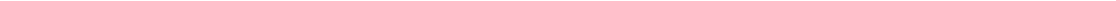
Fig. 2 The basal yeast thiol oxidation landscape. a Distribution of the in vivo oxidation status of 4,457 unique cysteine-containing peptides. The dataset was classi fi ed into four oxidation groups as indicated. For each group, a representative peptide (red) and the respective extracted ion chromatogram (XIC; right) are shown. XICs display the redox state of (I) Cys157 of the methionine-R-sulfoxide reductase Mxr2, (II) Cys107 of the translational mRNA activator Gis2, (III) Cys166 of the thiol oxidase Ero1 and (IV) Cys147 of the cytosolic superoxide dismutase Sod1. Red line, light peptide peak (oxidised); blue line, heavy peptide peak (reduced). b Top: schematic illustration of the thiol-trapping approach. The reduced cysteine residue of a protein is alkylated by iodoacetamide (IAA). The oxidised cysteine residue is reduced by TCEP and is thus accessible for the thiol-modifying agent AMS or mPEG. Modi fi cation results in a shift of 0.5 or 1.2 kDa, respectively, per modi fi ed cysteine residue. Bottom: when indicated, proteins of total yeast cell extracts were incubated with 10 mM IAA, 50 mM TCEP and 10 mM AMS or 10 mM mPEG. As a control, one sample was incubated with 100 mM DTT. Proteins were separated by SDS-PAGE followed by immunodecoration with speci fi c antibodies. c Frequency of disul fi de bond (top) and zinc binding and/or zinc fi nger annotations (bottom) within different oxidation groups of cysteine-containing peptides as indicated. Other disul fi de forms include transient disul fi de bonds and those in linked or nuclear-retained form. d Distribution of proteins of different oxidation groups according to subcellular location. Gene ontology (GO) slim terms for cellular components were retrieved from the Saccharomyces genome database with the number of proteins in parenthesis. Proteins were grouped according to the most oxidised peptide. e GO term enrichment analysis of proteins with peptides in the oxidation range 15 – 30% (left) and 60 – 100% (right). For each term, the number of proteins is